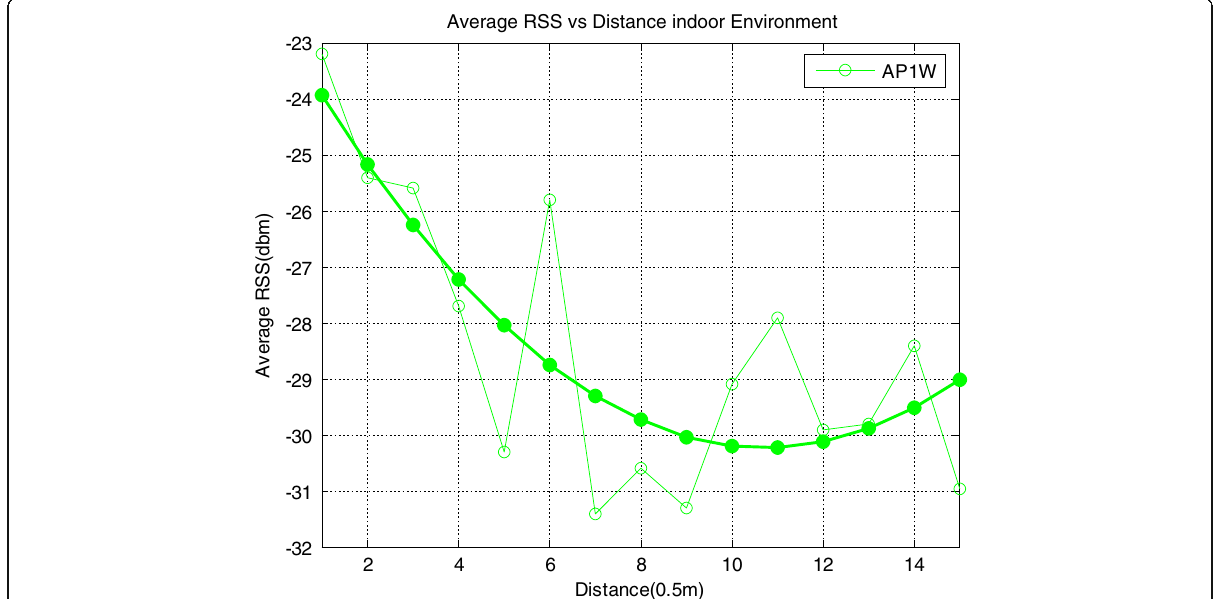
Fig. 6 The right corridor RSS signal changes (left). In the right corridor, AP 1 RSS ’ s